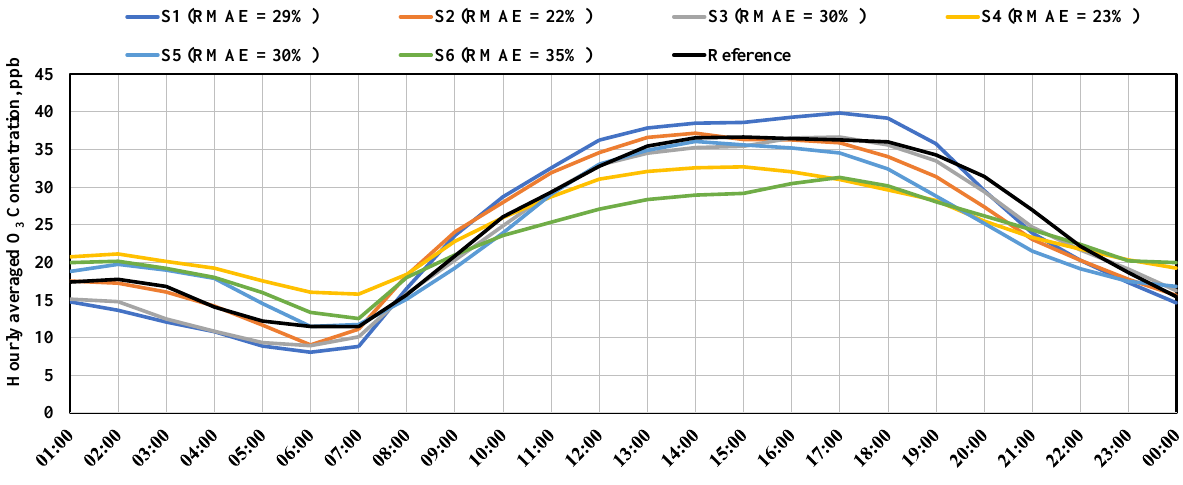
Figure 5. Hourly averaged O 3 concentrations based on AirSENCE™ and reference measurements for weekdays in the month of August 2019 in the GTA Satellite Smart City, Ontario. Relative mean absolute errors are indicated for each AirSENCE™ device.